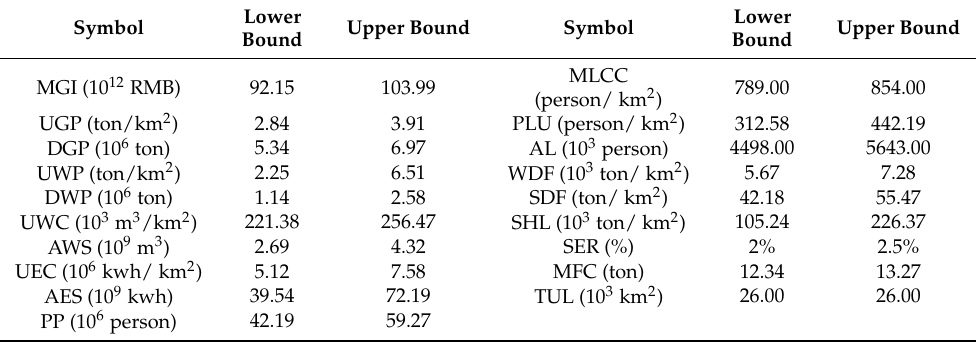
Table A4. Social/economical parameters.